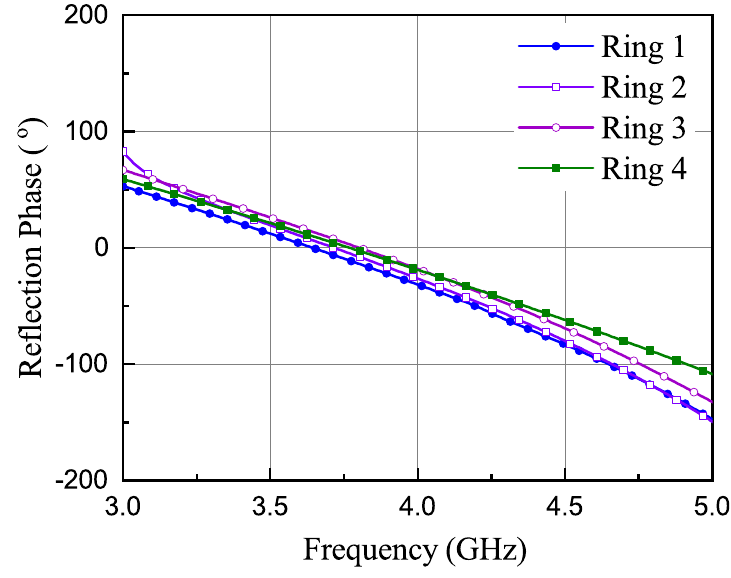
Figure 5. Phase response of four circular HIS rings.